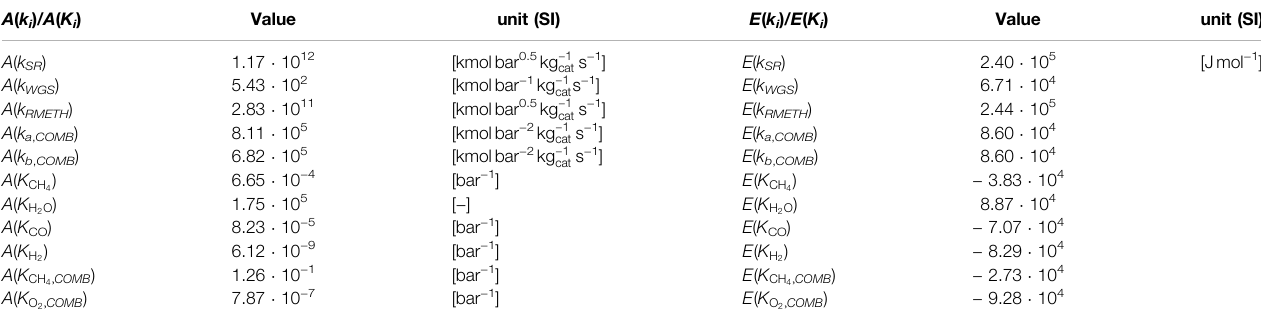
TABLE 4 | List of parameters for TRI kinetics: pre-exponential and activation